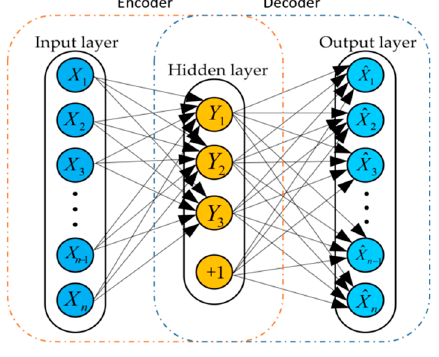
Figure 4. Structure of autoencoder (AE).